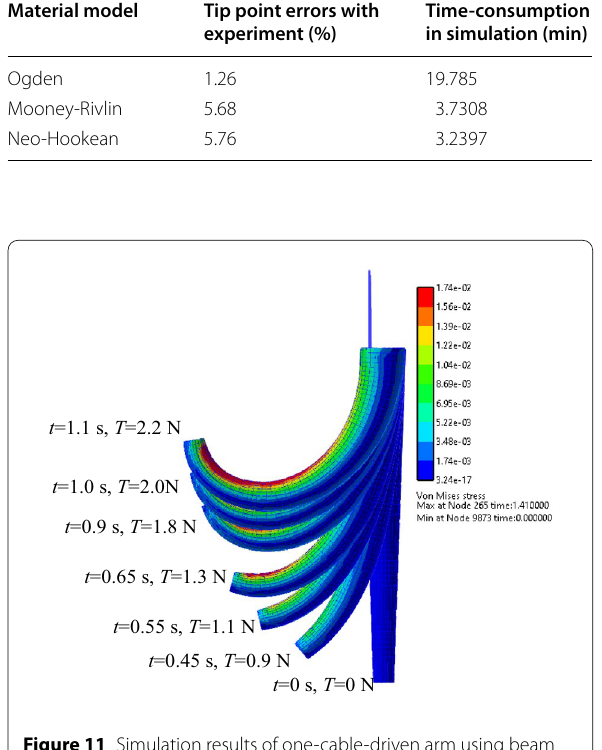
Figure 11 Simulation results of one-cable-driven arm using beam element